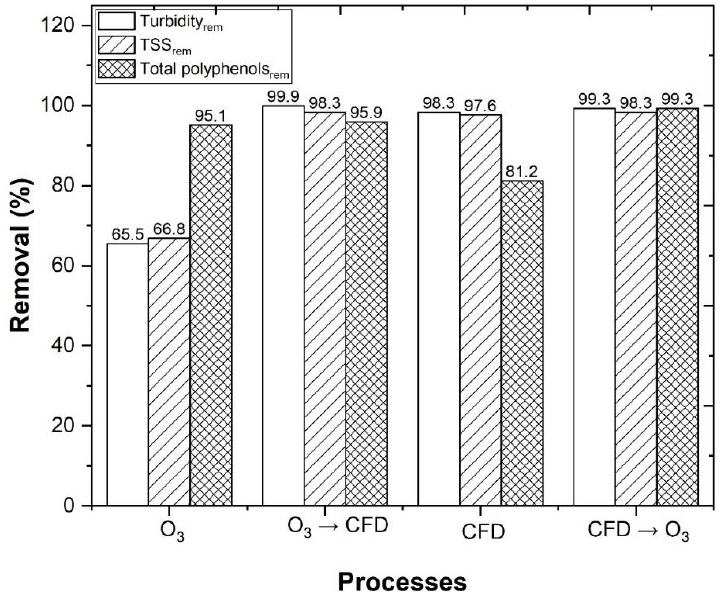
Figure 10. Turbidity, TSS and total polyphenol removal. The following CFD operational condi- tions: 0.48 g/L potassium caseinate, 0.52 g/L bentonite, pH 4.0, temperature 298 K, rapid mix 150 rpm/3 min, slow mix 20 rpm/20 min, sedimentation time 12 h. O 3 /Fe 2+ /UV-C experimental conditions, as follows: pH = 4.0, [Fe 2+ ] = 1.0 mM, ozone flow rate 5 mg/min, air flow 1.0 L/min, agitation 350 rpm, time 600 min, radiation UV-C mercury lamp (254 nm).